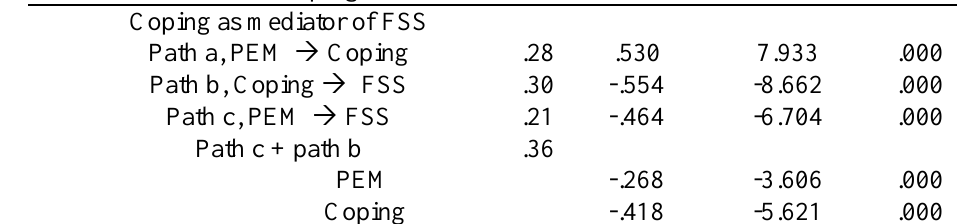
Linear Models testing: PDSS  LTPA  PEM  Coping  PBS or FSS Variables and paths